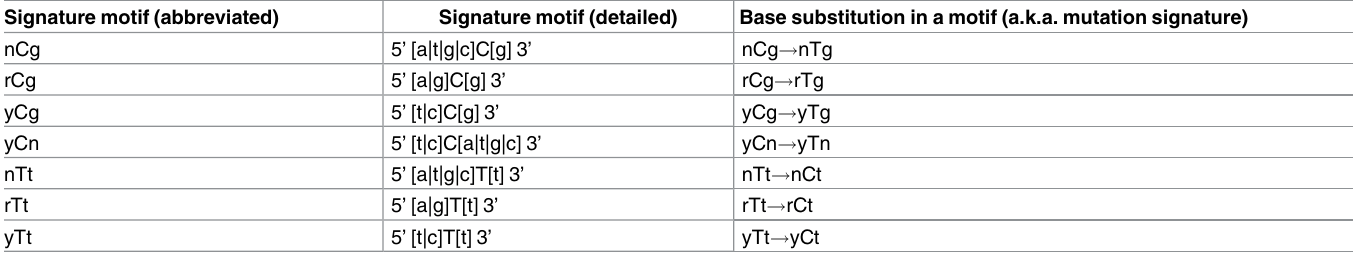
Table 2. Mutation signatures analyzed in this